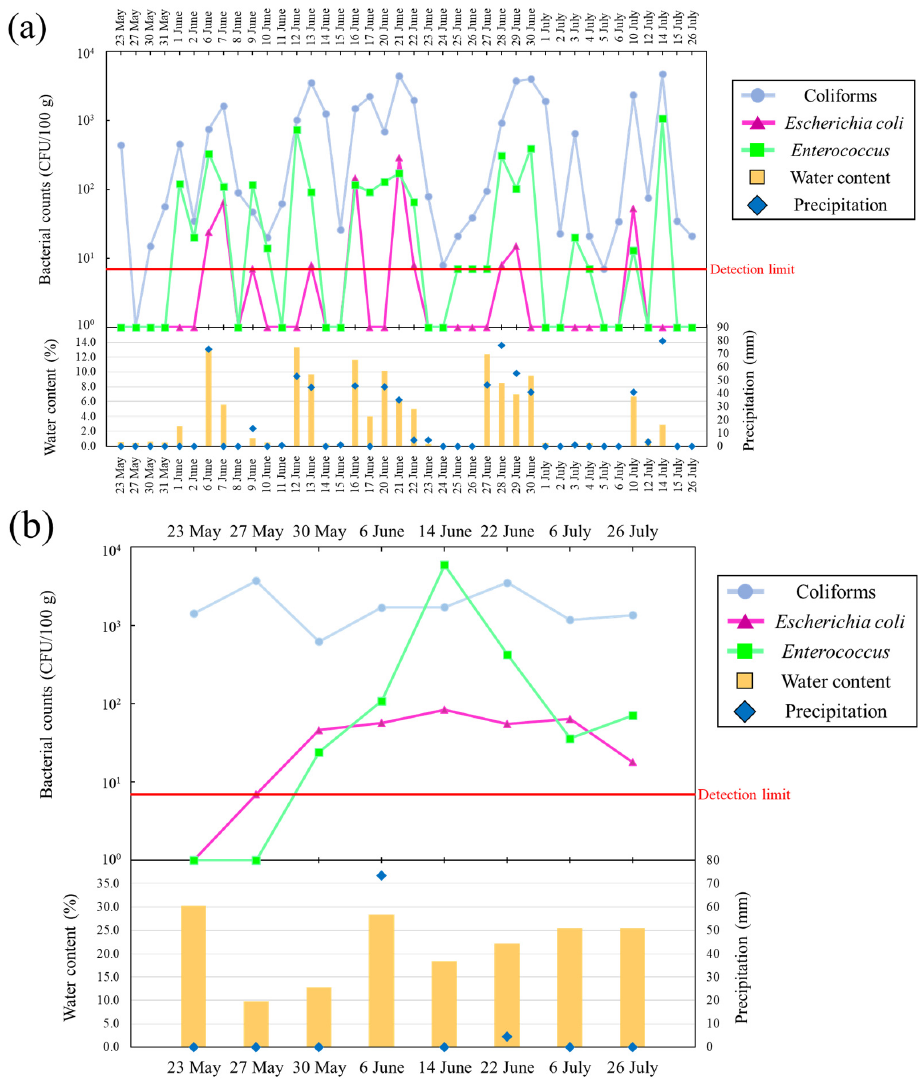
Figure 2. ( a ) Variation of Escherichia coli , coliform, and Enterococcus counts in supratidal top surface sand; water content; and precipitation at Kizaki Beach. ( b ) Variation of Escherichia coli , coliform, and Enterococcus counts in intertidal top surface sand; water content; and precipitation at Kizaki Beach.